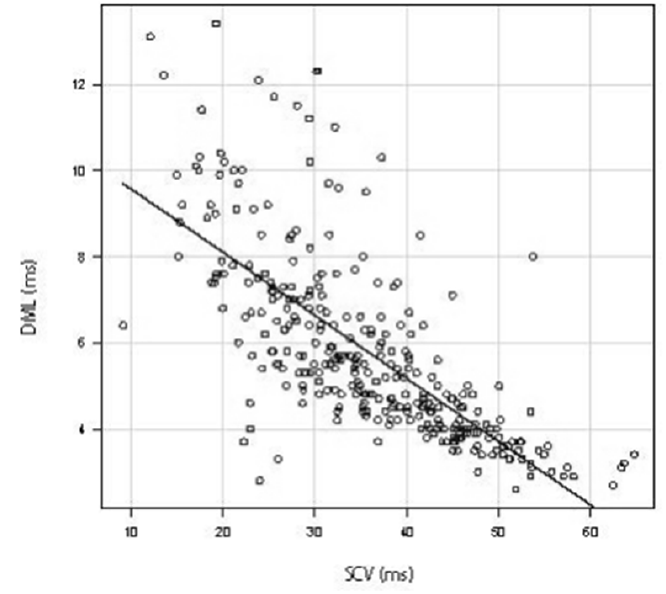
Figure 4. Scatter diagram between SCV and DML that excluded the patients with peripheral polyneuropathy or cervical disease and the postoperative patients. The straight line shows the correlation between SCV and DML. Abbreviations: DML, distal motor latency; SCV, sensory nerve conduction velocity.